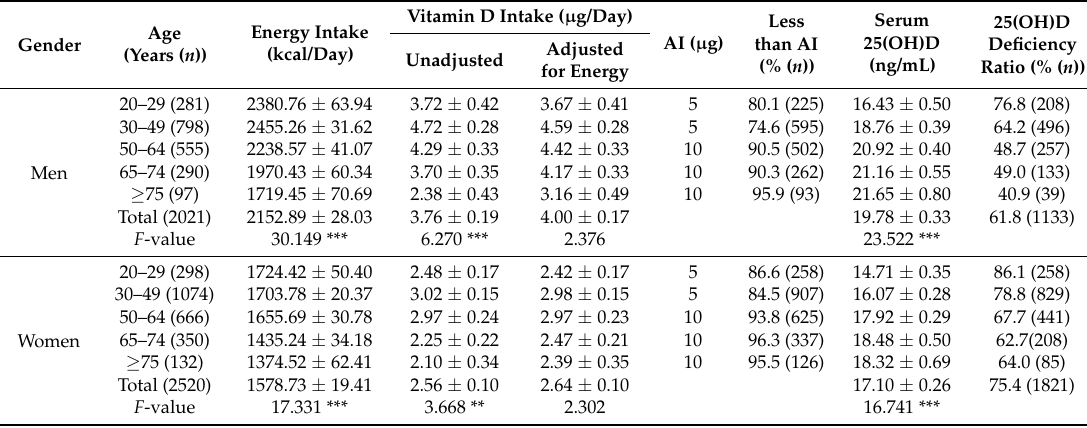
Table 2. Mean energy and vitamin D intakes and mean serum 25-hydroxyvitamin D concentration in Korea, 2009, by age and